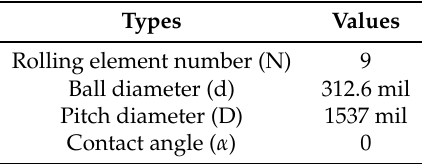
Table 2. Geometrical parameters of 6205-2RS JEM